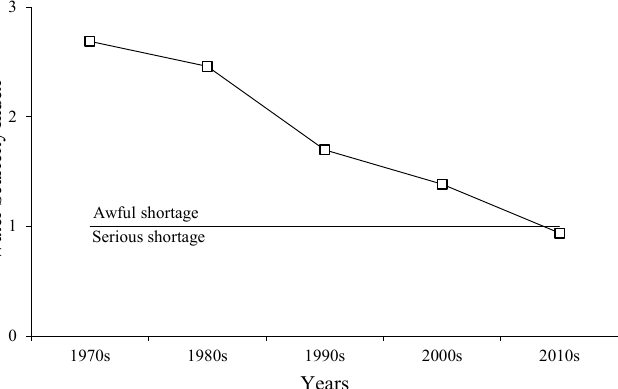
Figure 12. Distribution of WSI during the 1970s to 2010s. Notes: WSI, water scarcity index, over 1 means awful shortage of water resources in regional, and over 0.4 means serious shortage of water resources in regional.